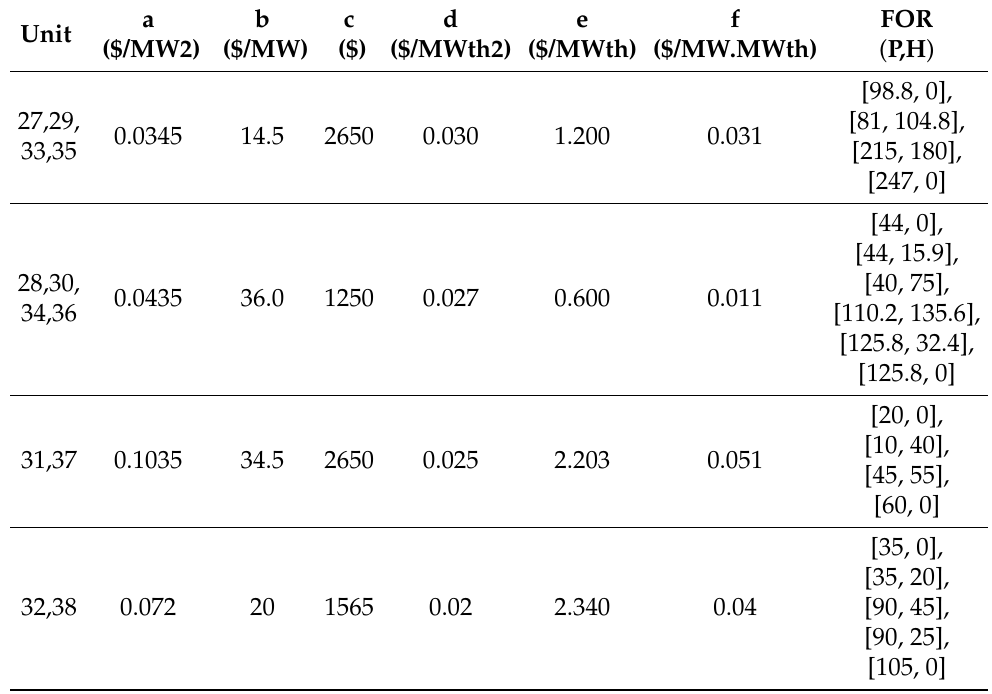
Table A14. Cogeneration unit data for Case Study 5.